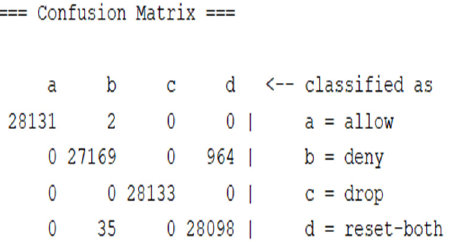
Figure 6. Confusion matrix for RF algorithm in the first experiment.